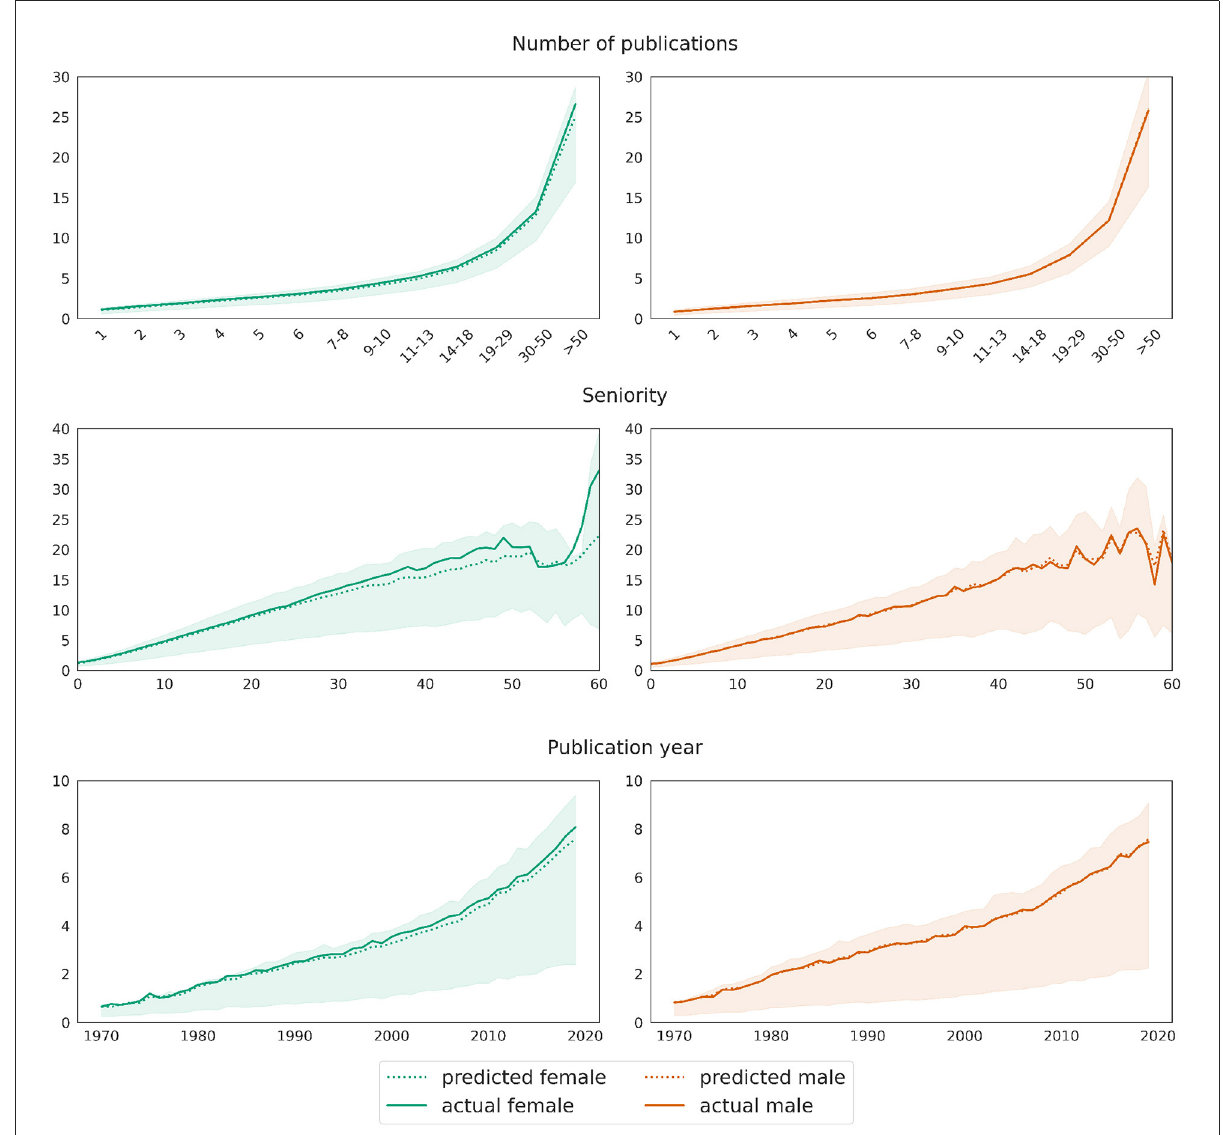
FIGURE7 Male baseline approach: mean differences between actual (solid curve) and predicted (dotted curves) values for the target variable network size . Shaded areas mark the [25,75] confidence interval of the ground truth